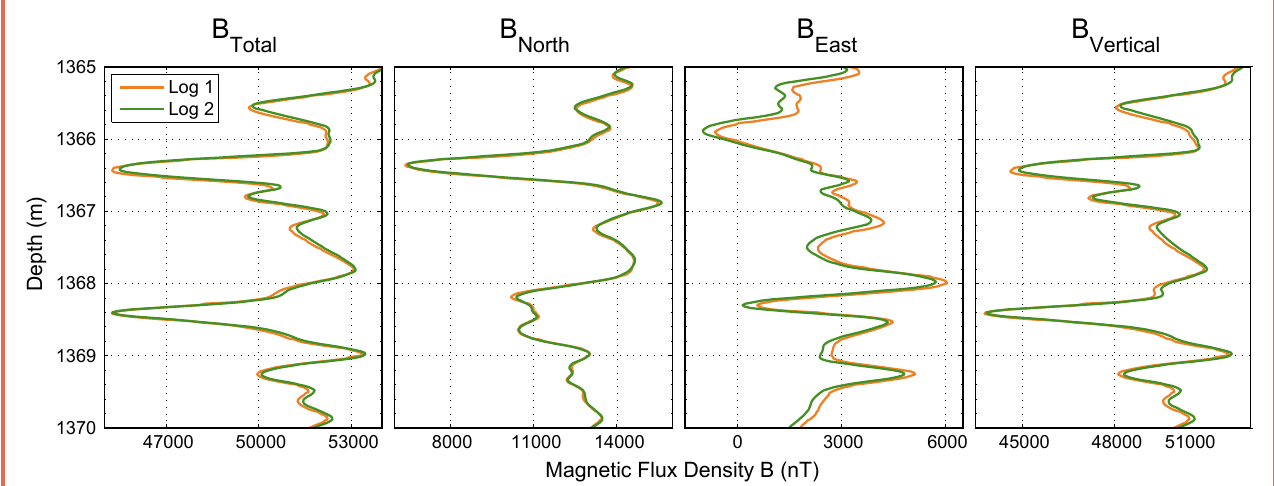
Figure 4. Comparison between two different logs, extract of strongly magnetized region. Each line represents the mean value of downlog and uplog.